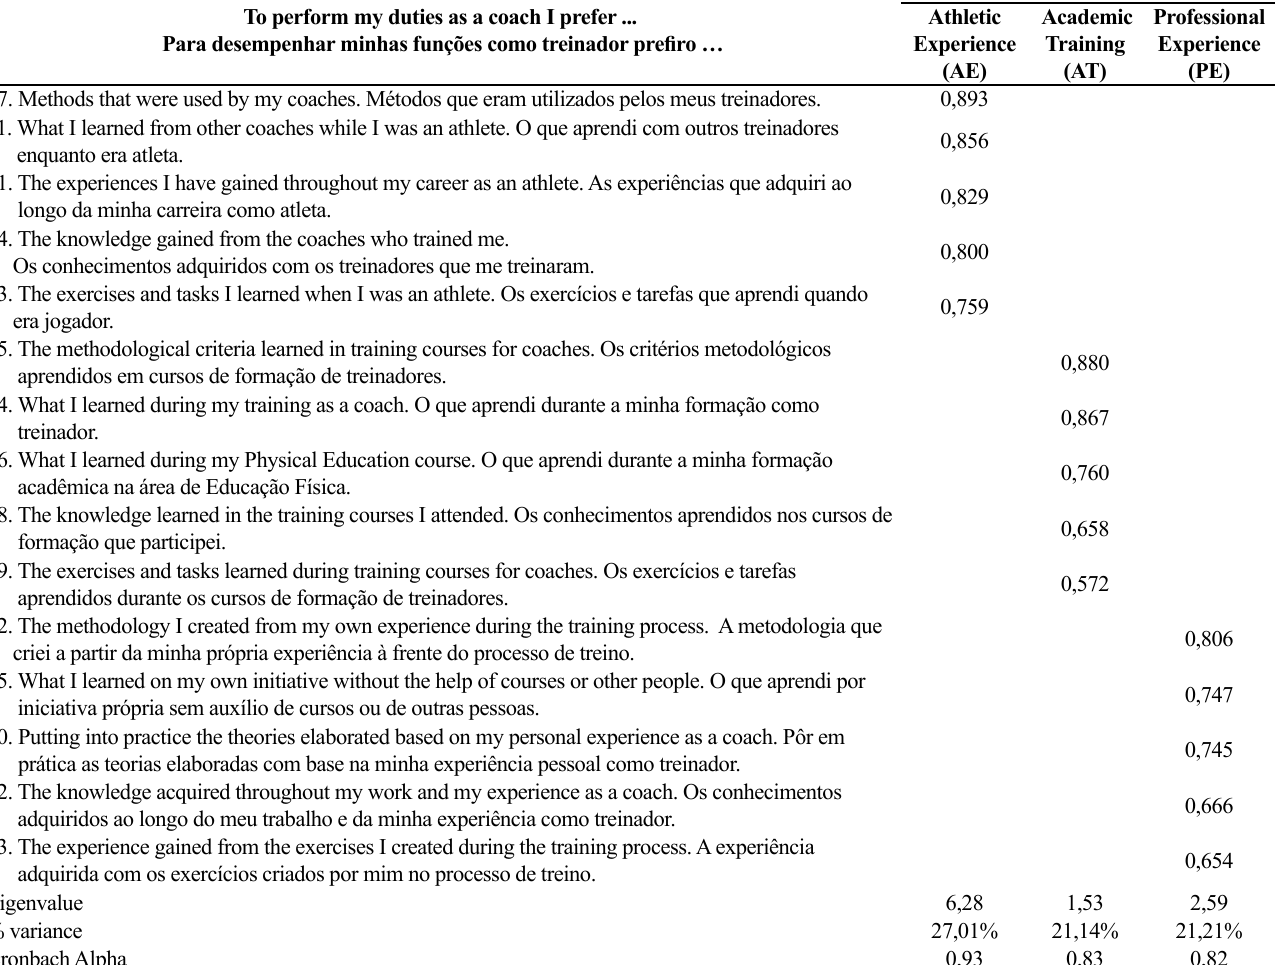
Table 2. Factor analysis of the QPFT with Varimax rotation (English and Portuguese version). To perform my duties as a coach I prefer